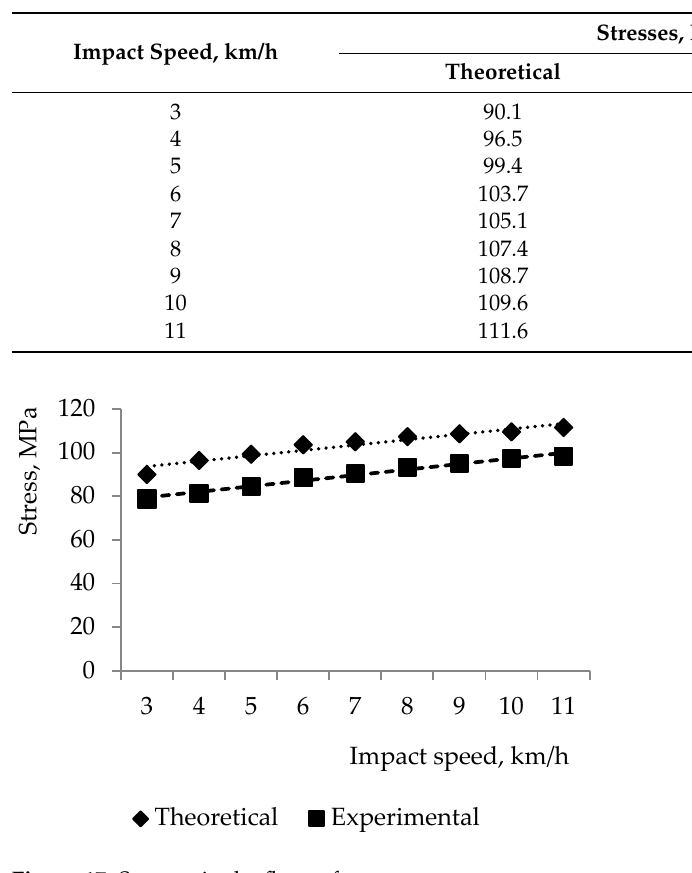
Figure 17. Stresses in the flatcar frame.